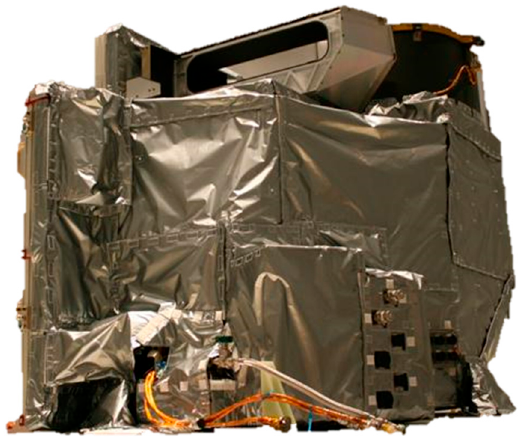
Figure 1. The Advanced Baseline Imager.